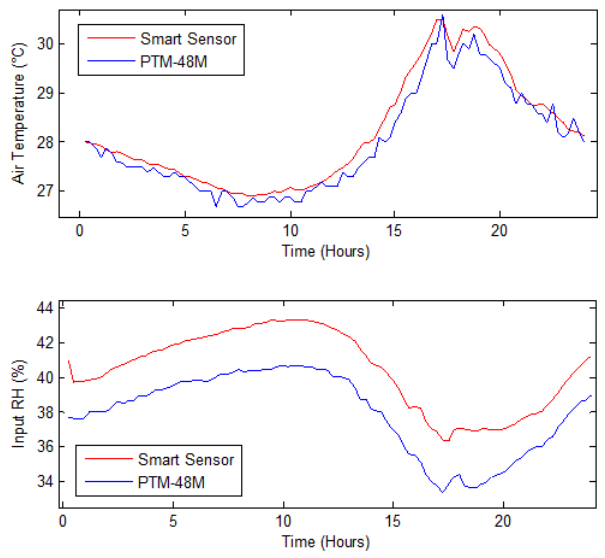
Figure 8. Primary sensors signal comparison. The proposed smart sensor signals are in red and Phytech PTM-48M readings in blue.